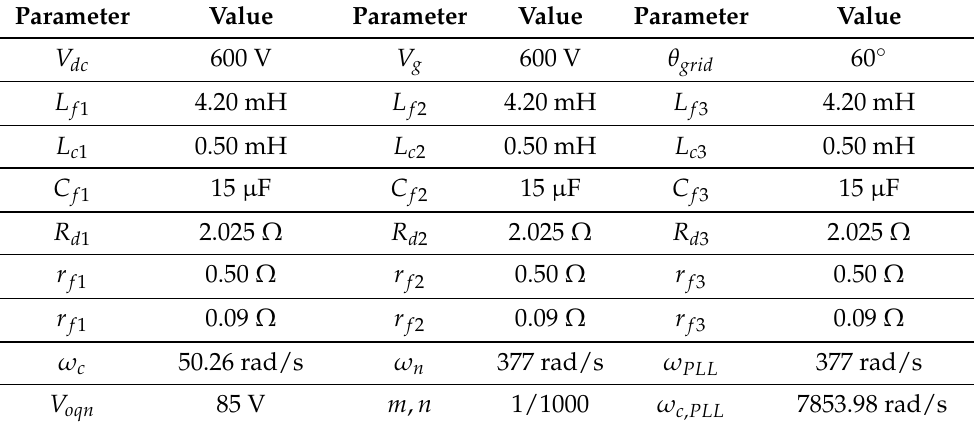
Table 1. Microgrid system